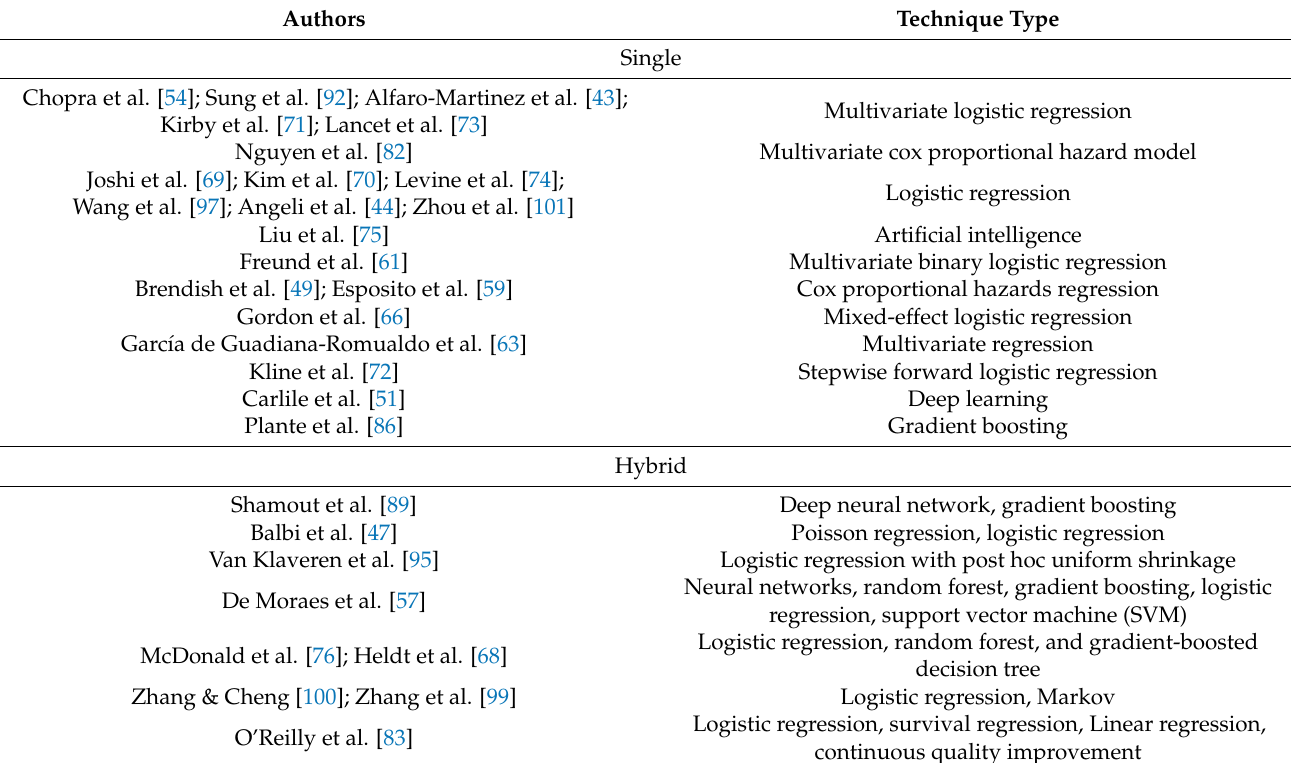
Table 4. Papers demonstrating the use of machine learning and data analytics techniques for augmenting the emergency department response to the COVID-19